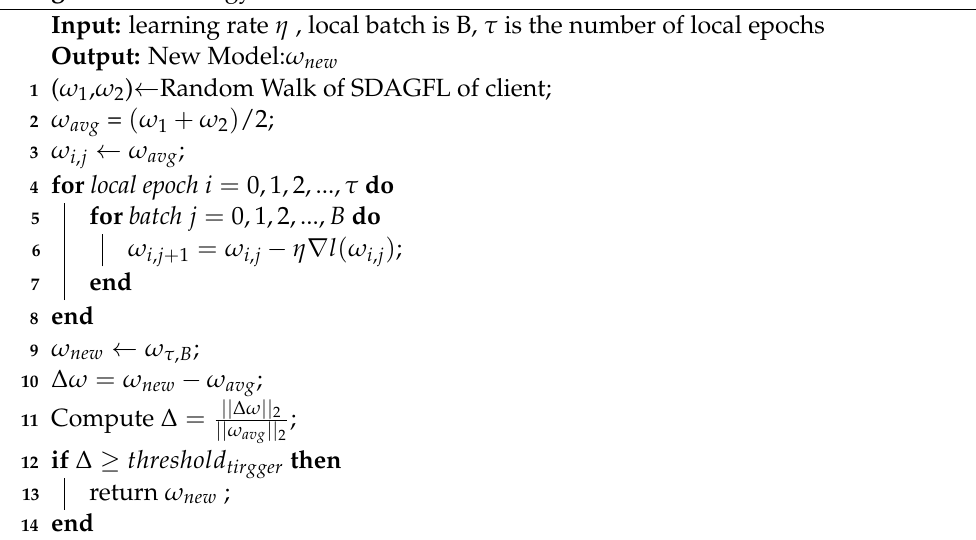
Algorithm 2: Energy efficient SDAGFL scheme.